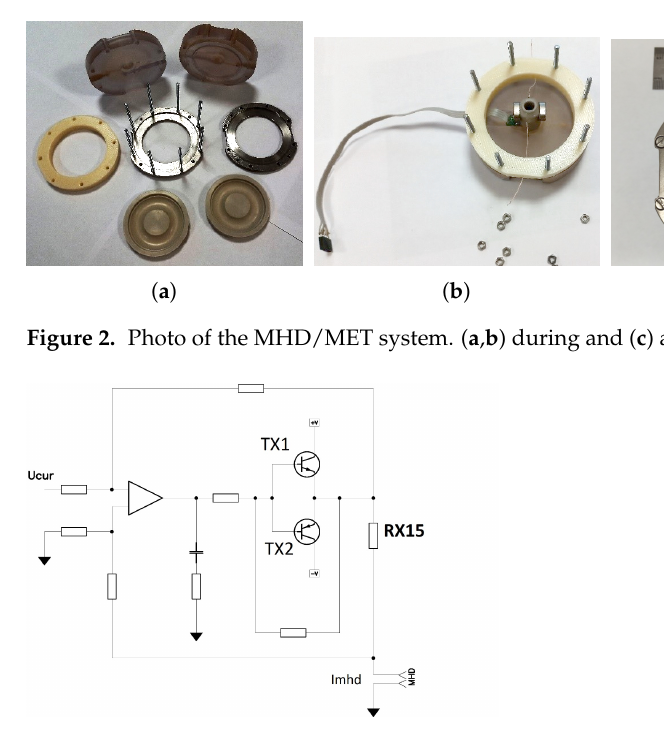
Figure 1. Schematic diagram and layout of the MHD/MET system. ( a ) The scheme, where 1 is pair of electrodes of an MHD cell, placed in a magnetic field of permanent NdFeB magnets 2, 3 is MET cell, 4 is glass ceramics channel; ( b ) The device.